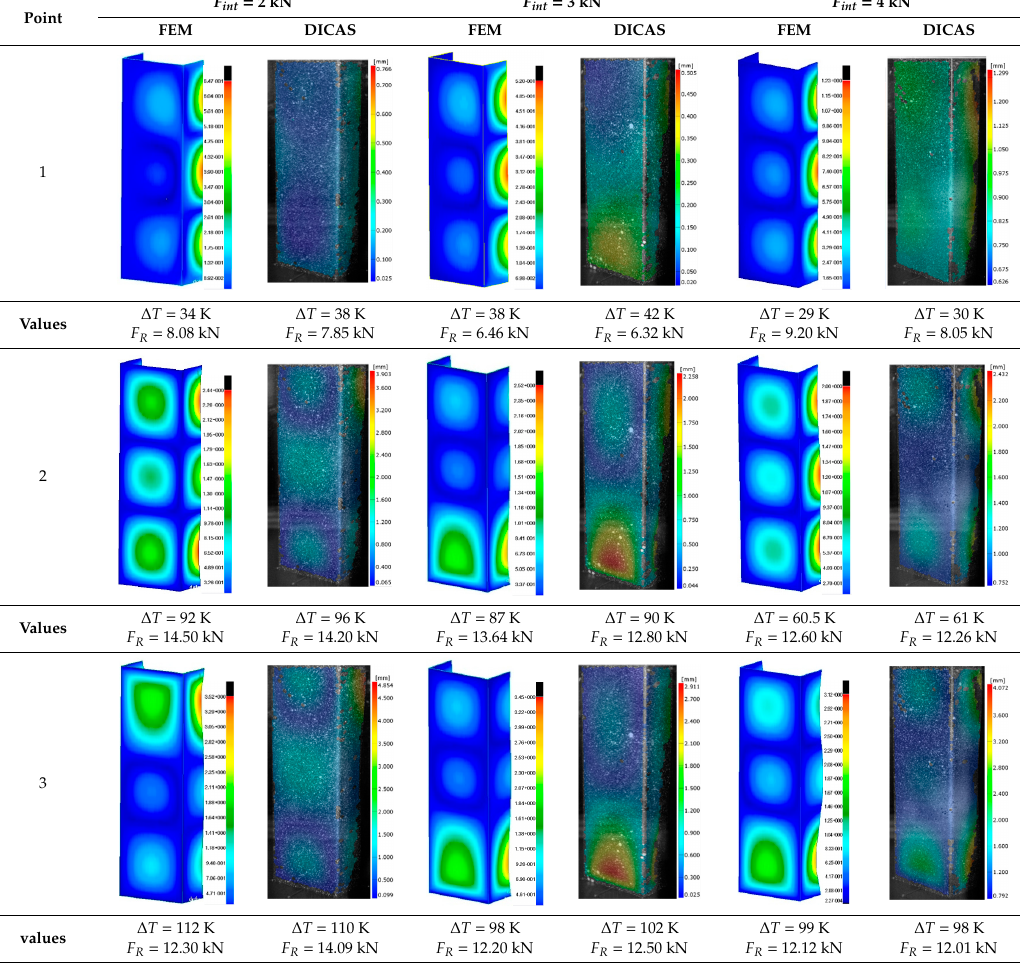
Δ T = 112 Kziwei values F R = 12.30 kN